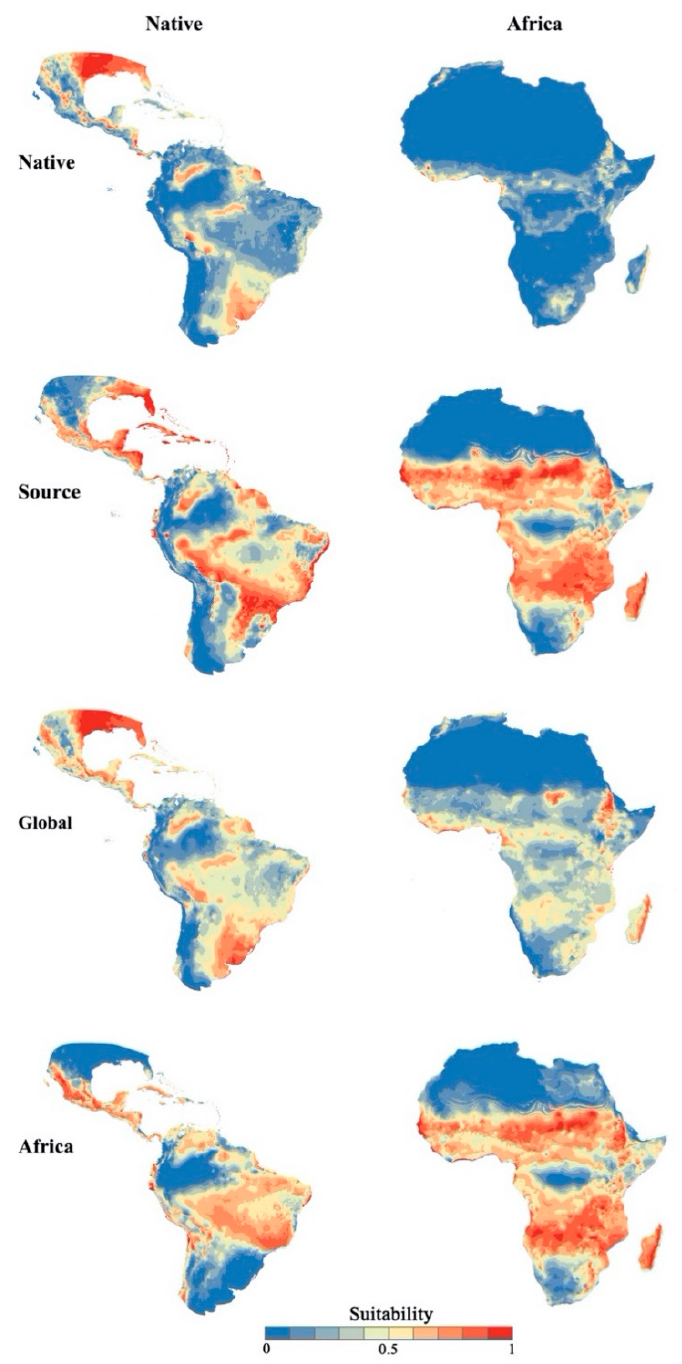
Figure 3. Projections of ecological niche models based on data from the world, source, global and Africa ranges of Spodoptera